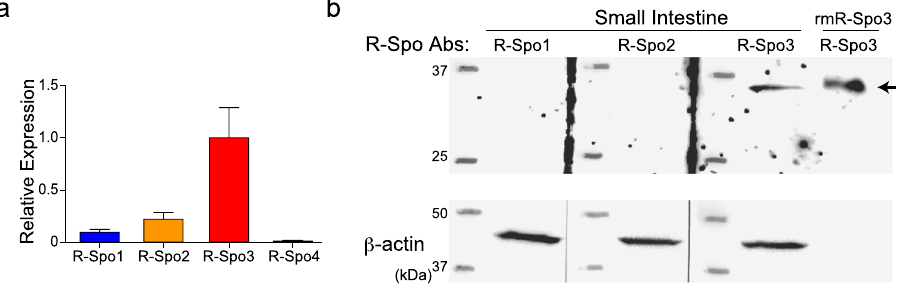
Figure 1. R-Spo3 is the major R-Spo molecule produced in the intestine. ( a ) mRNA was extracted from the small intestine of naïve B6D2F1 mice and subjected to quantitative PCR analysis of R-Spo family genes. Relative expressions of R-Spo 1-4 normalized to 18S rRNA from one of two independent experiments with similar results is shown as the means ± SE of n-fold difference relative to the expression of R-Spo3 (n = 6/group). ( b ) R-Spo1, R-Spo2, and R-Spo3 proteins as well as β -actin as a loading control in the lysates of small intestines of naïve B6D2F1 mice were detected by western blotting. Cropped images for R-Spo bands (top), and β -actin bands taken with shorter exposure time than that for R-Spondins (bottom) are shown. Images of full length gel with ranged exposure times are shown in Supplementary Figure 1. Recombinant mouse R-Spo3 (rm-R-Spo3) was applied on the far-right lane as a control